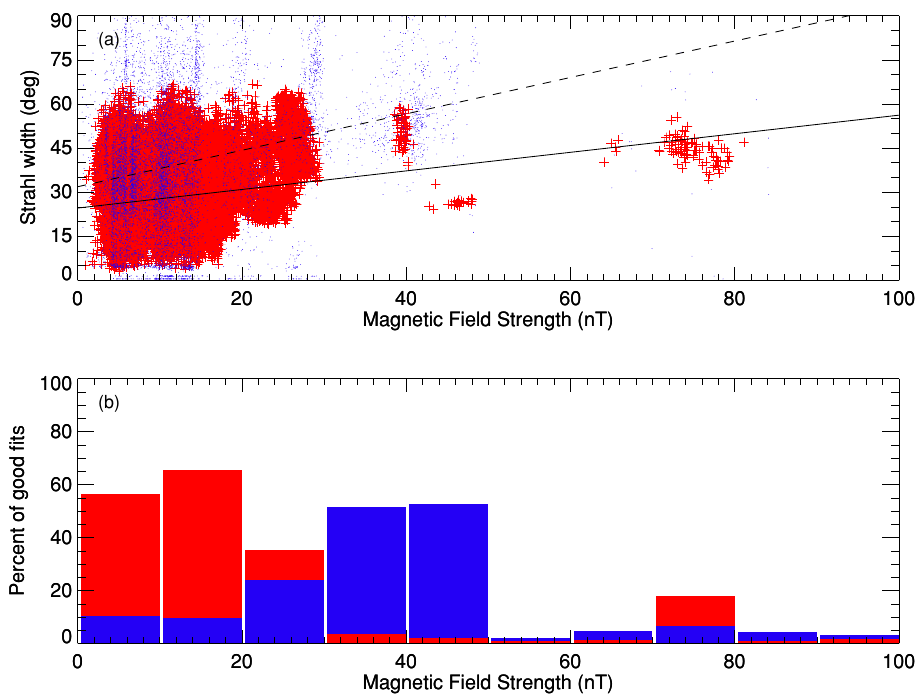
Figure 3. Characteristics and occurrence rates for anti-sunward strahl beams and sunward deficits as a function of magnetic field strength. ( a ) Scatter plots of the pitch angle width of the strahl (red points) and deficits (blue points) as a function of magnetic field strength observed during the sample. Best fit straight lines to the data are over-plotted (strahl—solid line; deficit—dashed line); ( b ) Occurrence rate histograms, in 10 nT bins, for the strahl (red) and deficit (blue) samples. The data are plotted as a percentage of the total number of good fits to samples taken in the relevant magnetic field strength bins. Note that the height of the blue bars has been increased by a factor of 2 to aid